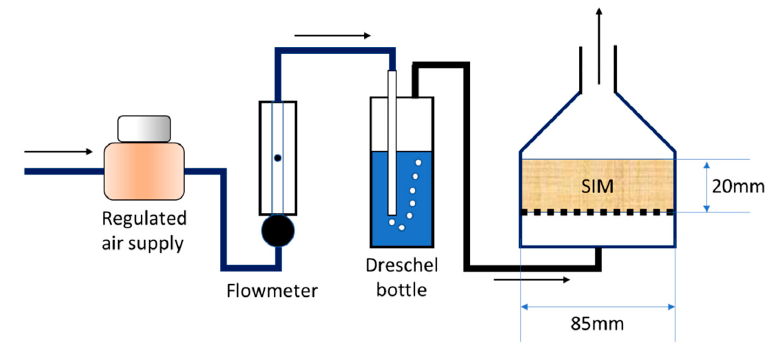
Figure 2. Schematic of experimental apparatus.